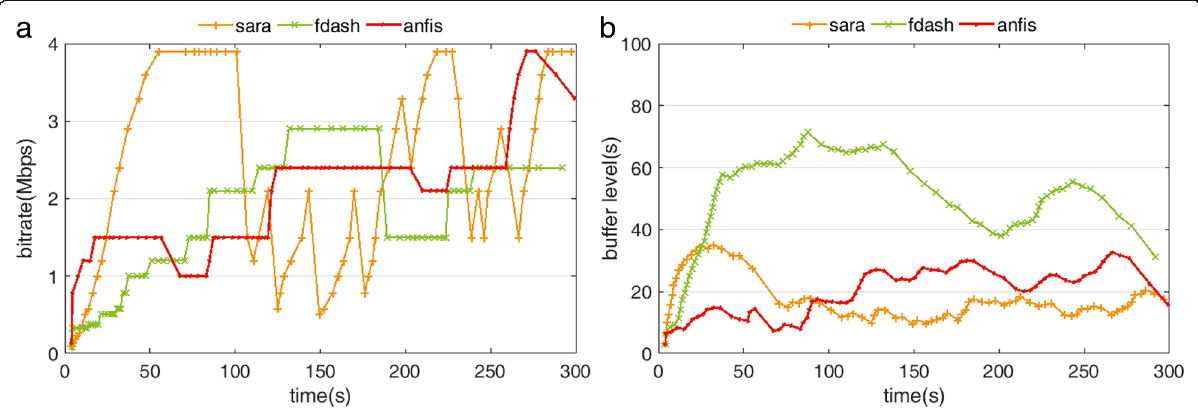
Fig. 6 Simulation results in first Wi-Fi environment. a The segment bit rate requested by client over time. b The client ’ s playback buffer level